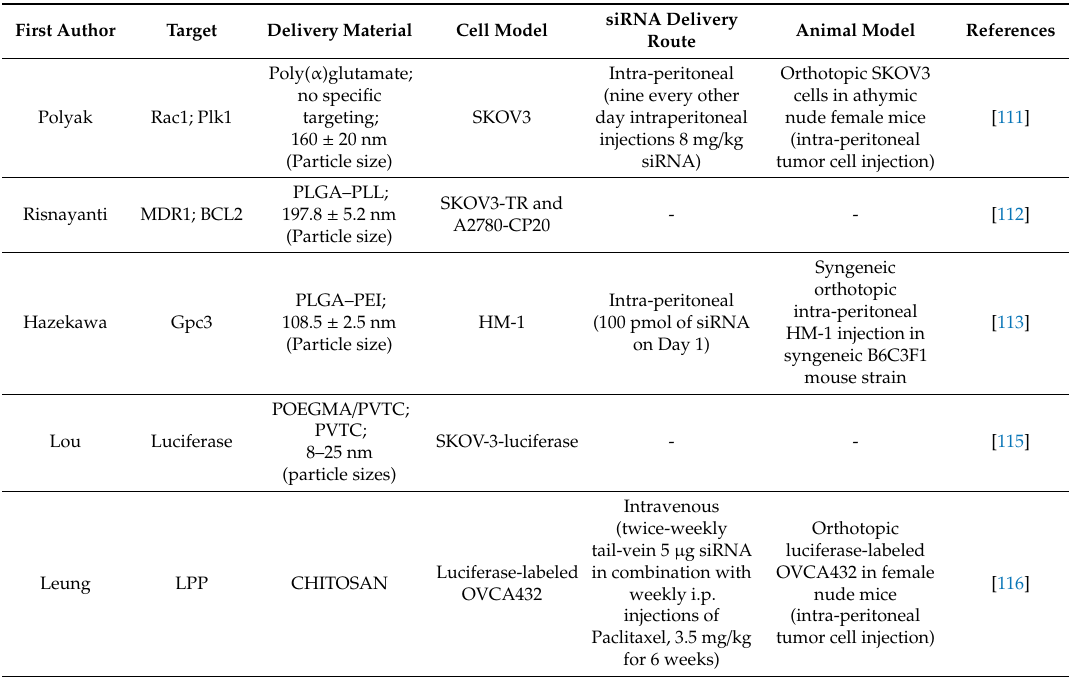
Table 5. Polymer based delivery systems without an OC-targeting